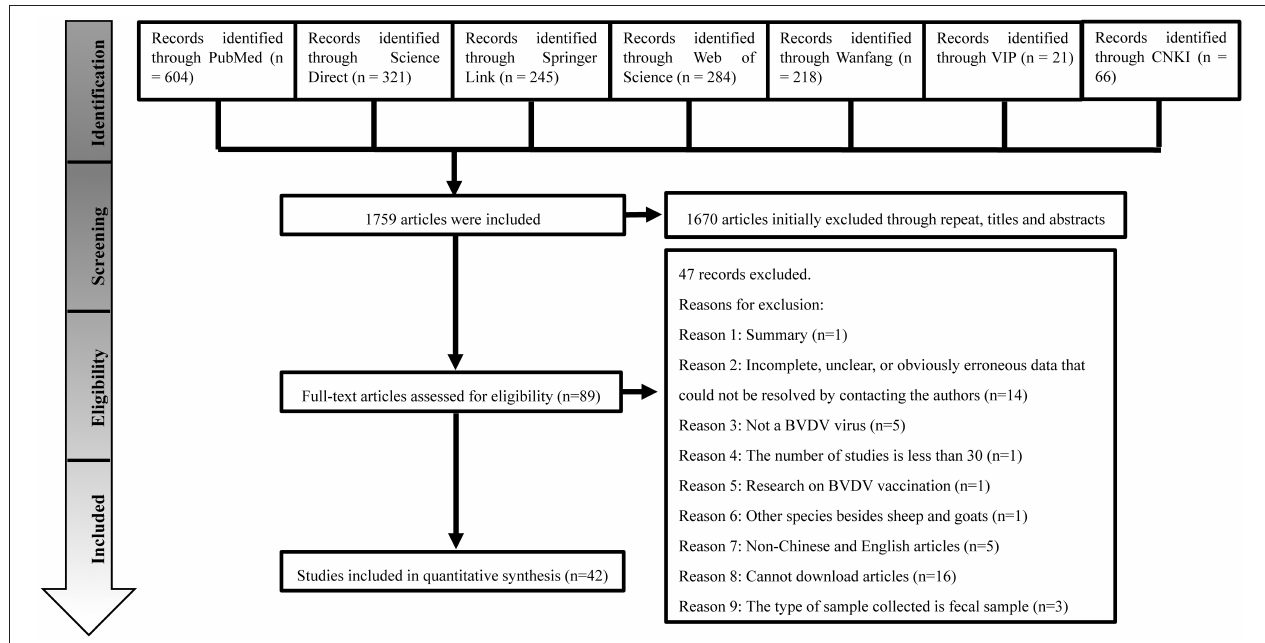
FIGURE 1 | The selection process showing inclusion and exclusion of